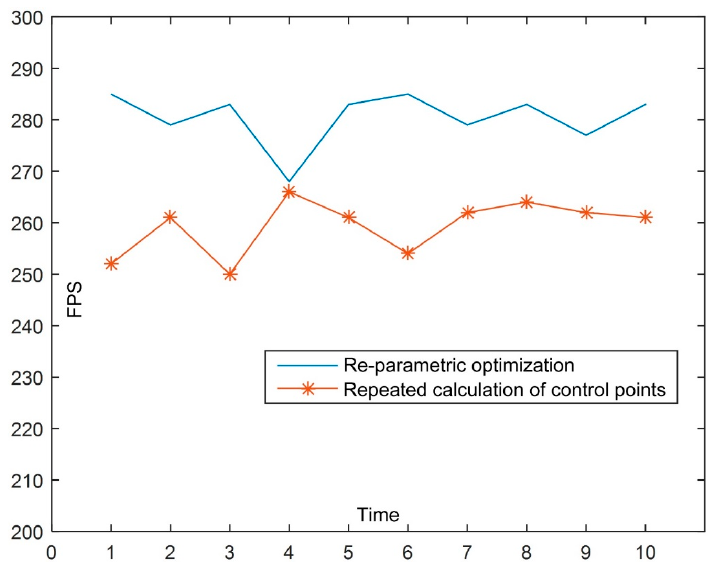
Figure 10. Comparison of the FPS optimization effect.